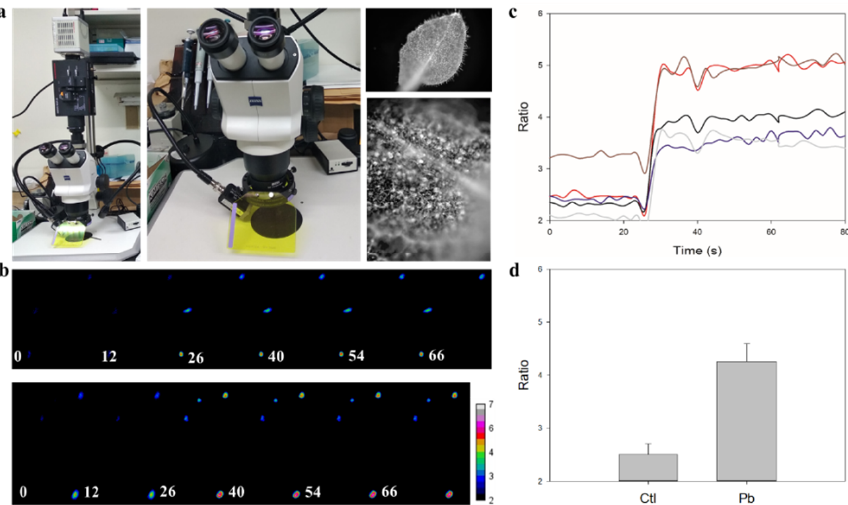
5 of 14 Figure 1. The predicted structure of Met-lead. Structural data from the MerR family member CueR [30] suggest that the lead sensing key (the PbrR protein, partial) is a dimer (shown in either gray or black for another strand in the homology modeling). Thus, the structure of Met-lead may also, in dimer form, bind two lead ions (red circles). The fluorescence resonance energy transfer (FRET) protein ECFP(ΔC11) is displayed in either blue or light blue, and cpVenus is displayed in yellow or green. The two lead-binding pockets at the opposite edges of each PbrR-sensing domain near the two FRET pairs are composed of the three cystine residues shown in red. Inside Met-lead, FRET events may happen upon the occurrence of lead ions through the driving of these two pairs together to favor energy transfer [12,17,19,20]. 3.2. Real-Time In-Cell Biosensing of Lead Generally, an inverted FRET ratio imaging system is used for biosensing in single living cells [12,17,19,20]. To extend the application of Met-lead to different living organisms, such as fruit flies and plants, we for the first-time incorporated a FRET module into the stereo microscope (Figure 2a). Representative time-lapse emission ratio (cp173Venus/ECFP(ΔC11)) color images of Met-lead-expressing cells are shown in Figure 2b. Due to the presence of lead ions (10 μM, with the help of ionomycin, and at around 25 s after initiating the recording), the color of the ratio images of the five selected cells changed from blue to red (Figure 2b; Supplementary Movies 1 and 2). The emission ratio values within the same five selected cells all increased (Figure 2c). The bar graph